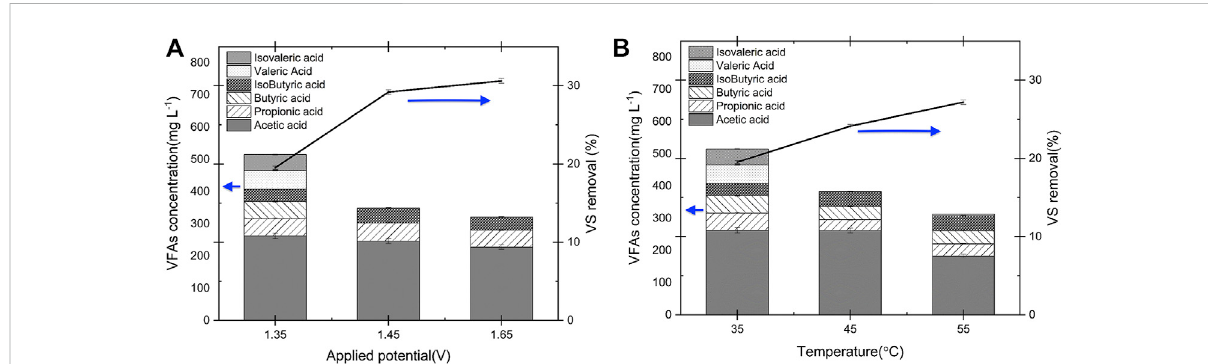
FIGURE 5 Comparison of VFAs concentrations during E-WAS with Cu electrode at 35 ° C in 0.2 M NaOH and 83 g L − 1 WAS after 1 h operation (A) different applied cell potentials. (B) at 1.35 V and 35 – 55 ° C operation temperature. VS. removal increased at higher operating temperature and applied potential. However, VFAs concentration signi fi cantly decreased. Highest total VFAs concentration was obtained at 35 ° C and 1.35 V.